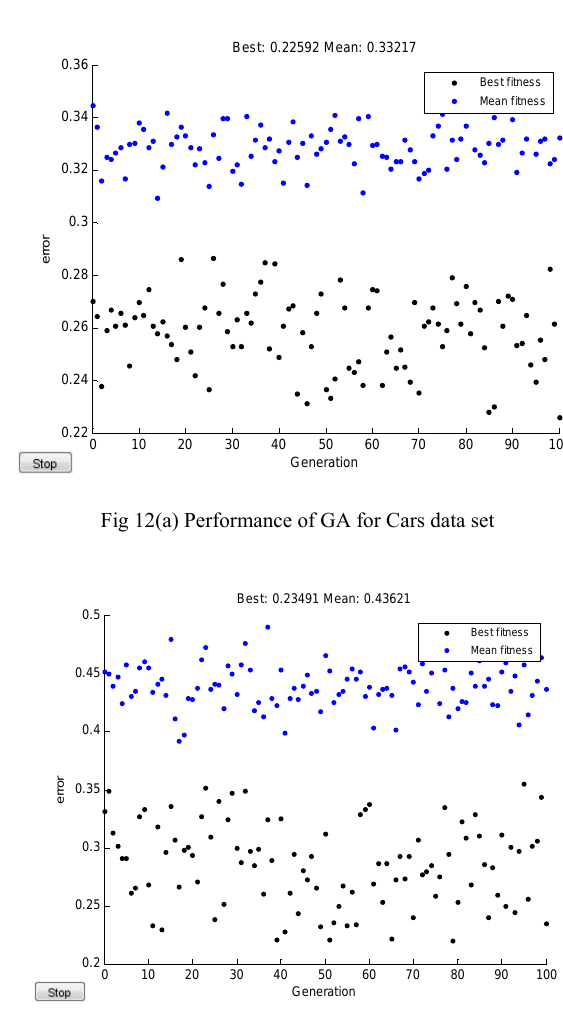
The back propagation has a final error of 0.018. The conventional GA converged in 18 generations, with an error of 1.9*10-21.The selectively cloned GA was far superior and converged in 12 generations with an error of almost 0. Thus selectively cloned GA has a convergence efficiency of 83.33% which is far superior to GA which is 55.55% efficient in comparison to back propagation. the back propagation converged in 6.7 seconds, while the conventional GA converged in 1.45 seconds and selectively cloned GA converged in 0.272